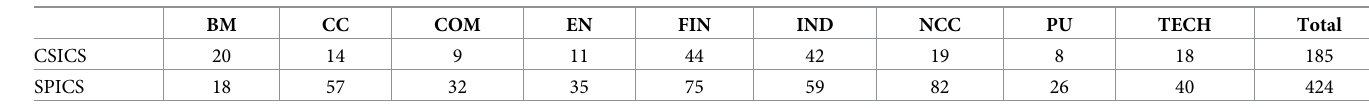
Table 3. The number of two index component stocks in various